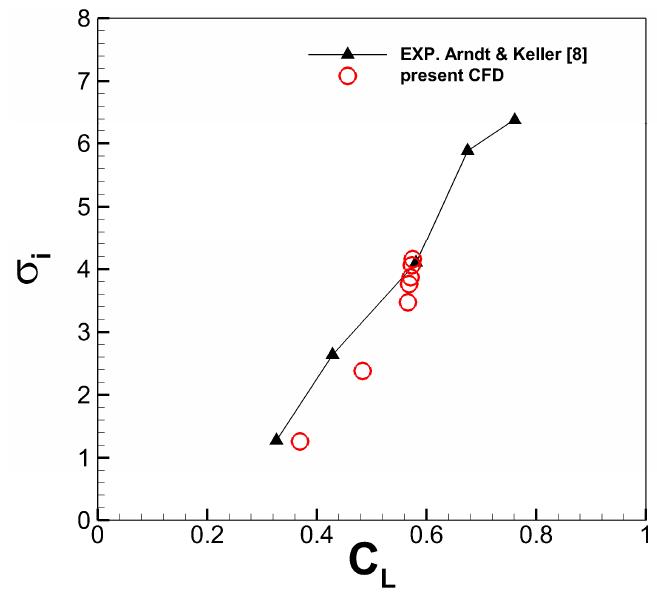
Figure 20. Cavitation inception index in weak water with the variation of the lift coefficient.